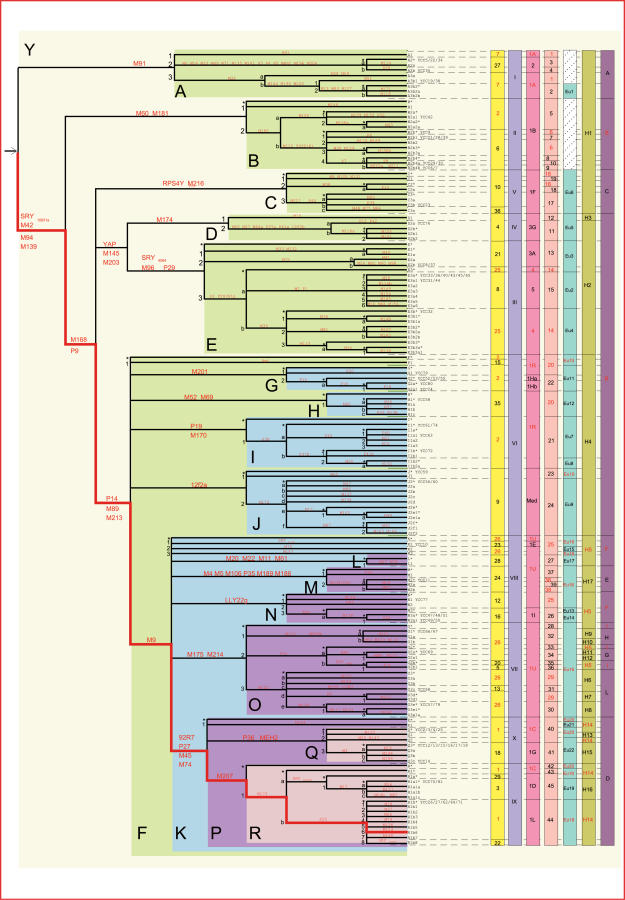
Chromosome Y ethno-genogeographic lineageThe HuRef donor Y chromosome haplotype suggests descent from several European/US groups given the Y chromosome ethno-geographic markers. The haplogroup membership is R1b6 with includes individuals from the United Kingdom, Germany, Russia, and the United States, which is consistent with the self-reported family tree provided by the HuRef donor. The thick red line denotes the markers needed to trace the haplotype from the mapping of the chromosome Y markers to the HuRef genome. Data and figure from the Y Chromosome Consortium; http://ycc.biosci.arizona.edu/nomenclature_system/frontpage.html.